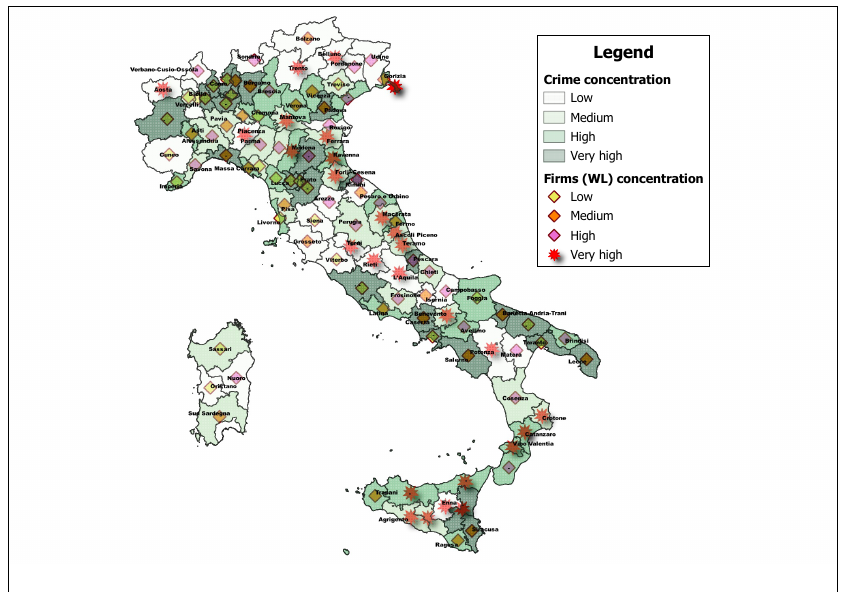
Figure 4. Organised crime variable and concentrations of firms (WL). Source: Authors processing of AIDA Bureau Van Dijk and Prefectures data.